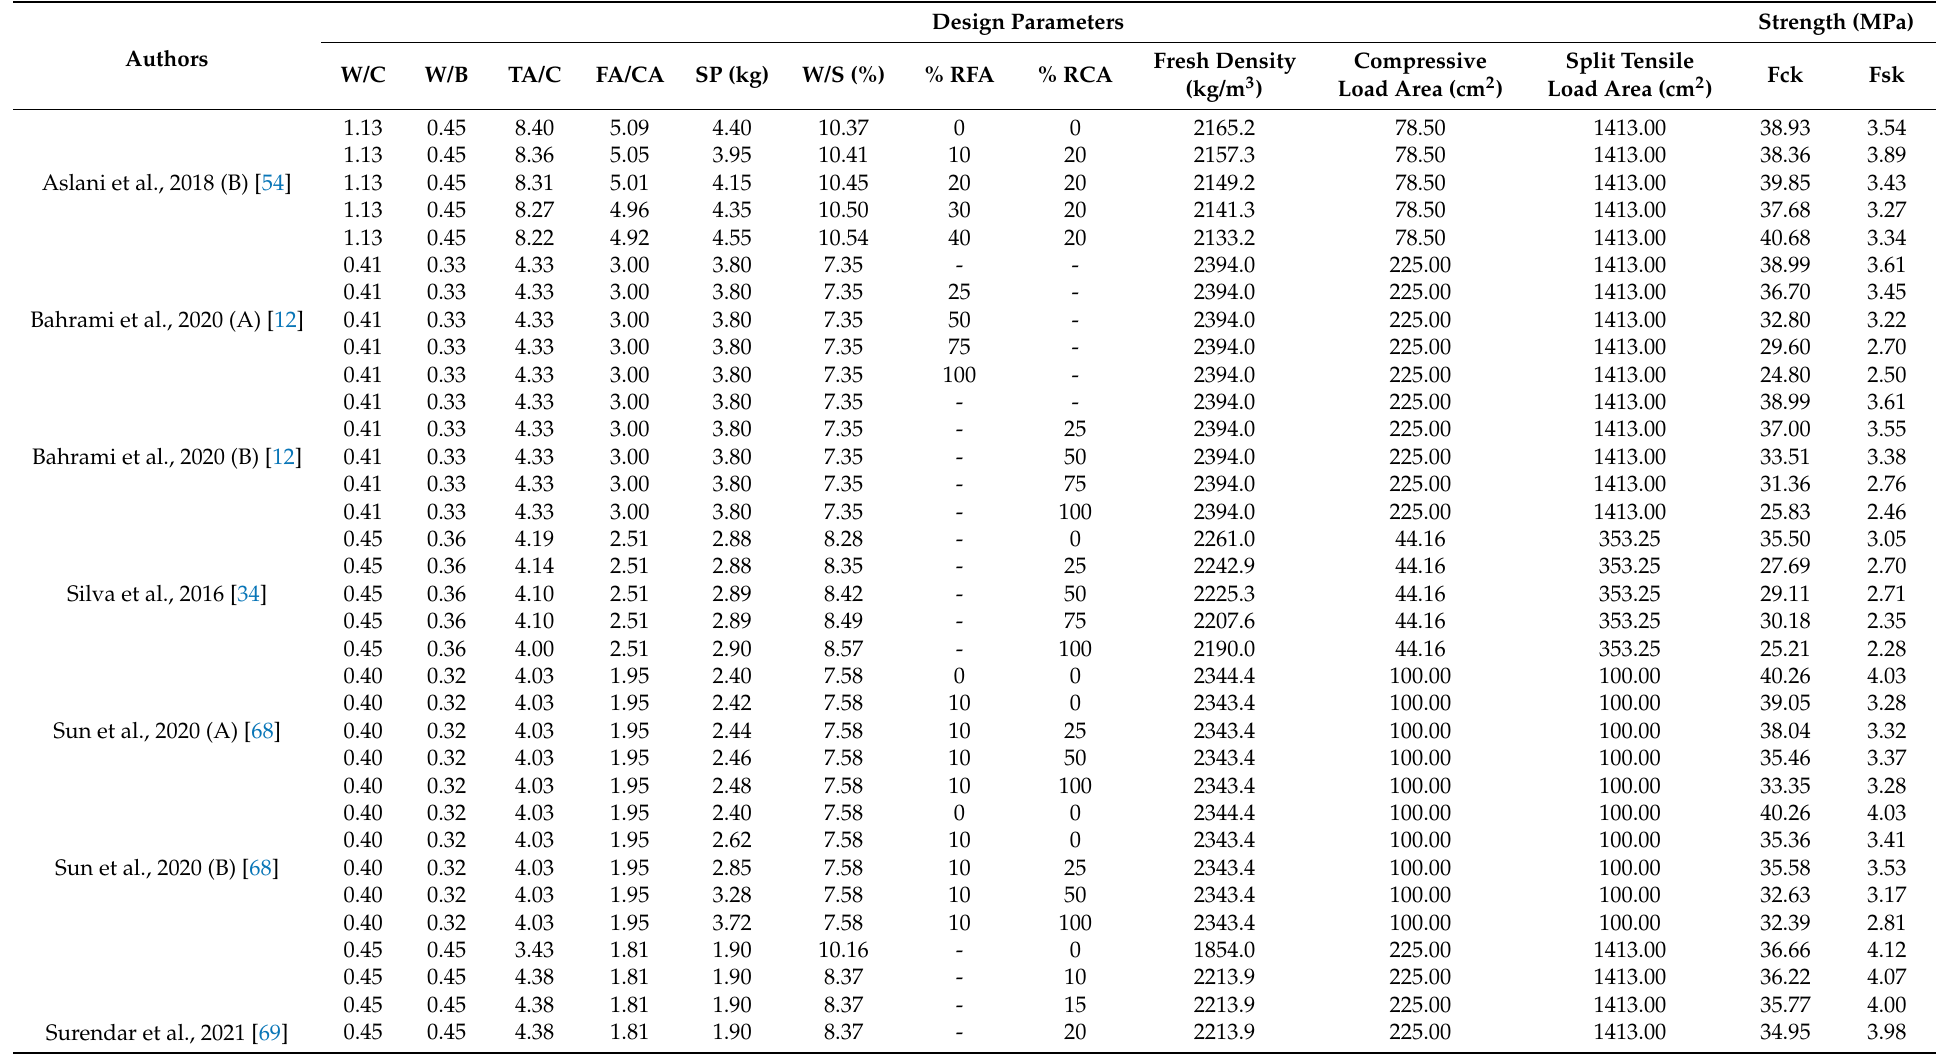
Table 5. Family V (Compressive strength range–30 MPa to 40 MPa) design parameters according to